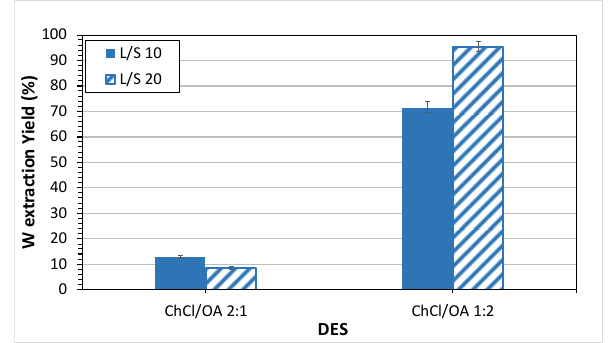
Figure 4. Effect of L/S ratio on W ext. Yield (T 60 °C, time 24 h). Surprisingly, W extraction yield did not increase with L/S for DES ChCl/OA 2:1. The hypothesis is that, at this high ChCl/OA ratio, an excess of choline chloride molecules